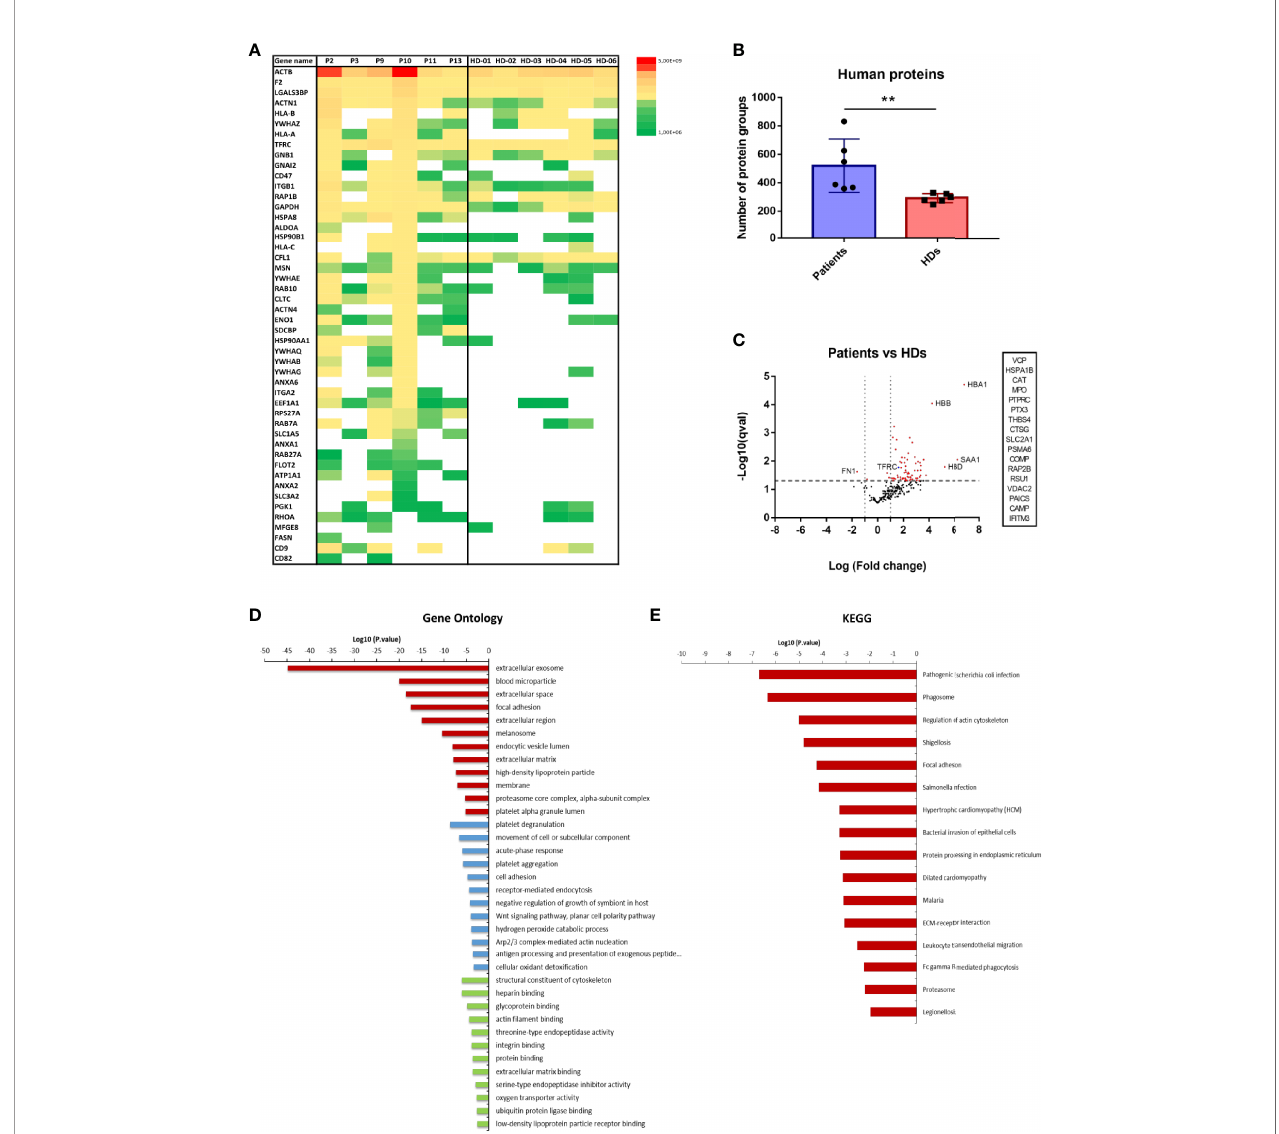
FIGURE 2 | Human proteome of CD71 + EVs isolated by direct immuno-af fi nity capture (DIC) from P. vivax patients and healthy donors (HDs). (A) EV markers distribution and abundance in patients and healthy donor groups. Cytoskeleton proteins (ACTN1, ACTN4, ACTB, MSN and RHOA), members of the Annexin family (ANXA1, ANXA2, ANXA6), cell signaling regulators (YWHAB, YWHAE, YWHAG, YWHAQ and YWHAZ), integrins (ITGB1 and LGALS3BP), molecular chaperones (HSP90AA1 and HSPA8), glycolytic enzymes (GAPDH, ALDOA, and ENO1), GTP-binding proteins (RAP1B), GTPases (RAB10, RAB7A, RAB27A), Guanine nucleotide-binding proteins (GNB1 and GNAI2), regulators of lipid synthesis (CD5L), antigen presenting proteins (HLA-A), transmembrane traf fi cking proteins (SDCBP), iron uptake (TFRC) and members of the tetraspanin family (CD9) among others. (B) Mean of the total number of human protein groups quanti fi ed in P. vivax patients (n=6) and healthy donors (n=6). Mann-Whitney test,** p <0.05. (C) Quantitative comparison of protein groups abundance of CD71 + EVs from P. vivax patients and healthy donors. Volcano plot representation showing proteins up and downregulated (statistical signi fi cance q-val <0.05). Proteins listed in the inset were uniquely identi fi ed in P. vivax patients. (D, E) Enrichment analysis of proteins upregulated in CD71 + EVs from P. vivax patients by Gene ontology (GO) (D) and KEGG (E) pathway analysis. GO enrichment analysis shows terms of Cellular component (red), Biological process (blue) and Molecular function (green). Supplementary Excel Files 1, 2 contain extended supporting data of these